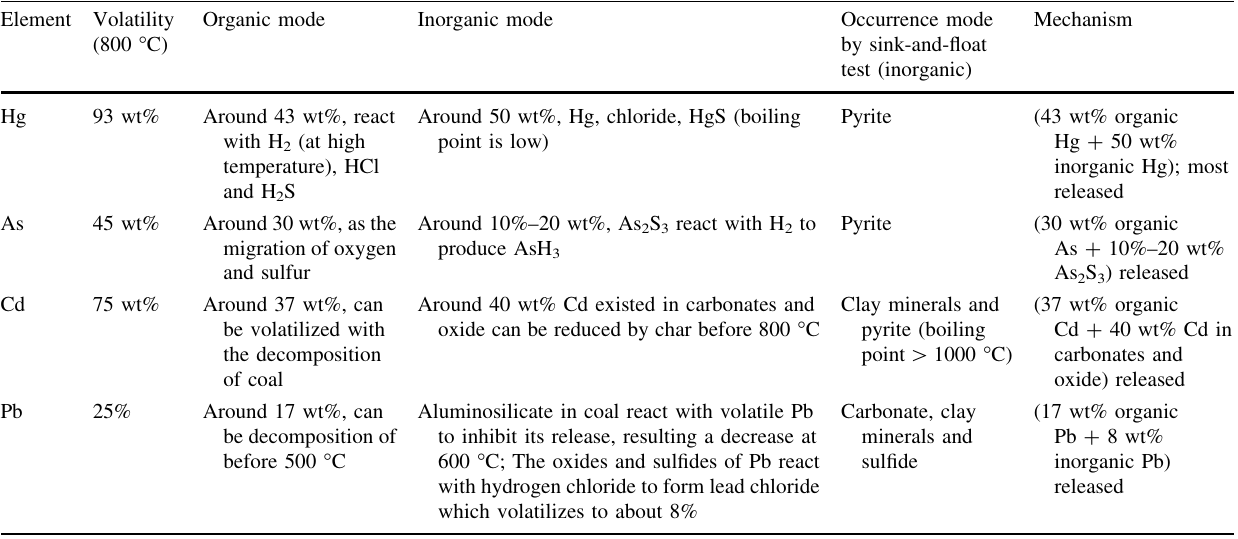
Table 5 Effect of occurrence mode on release behavior of heavy metal elements Element Volatility (800 (cid:3)